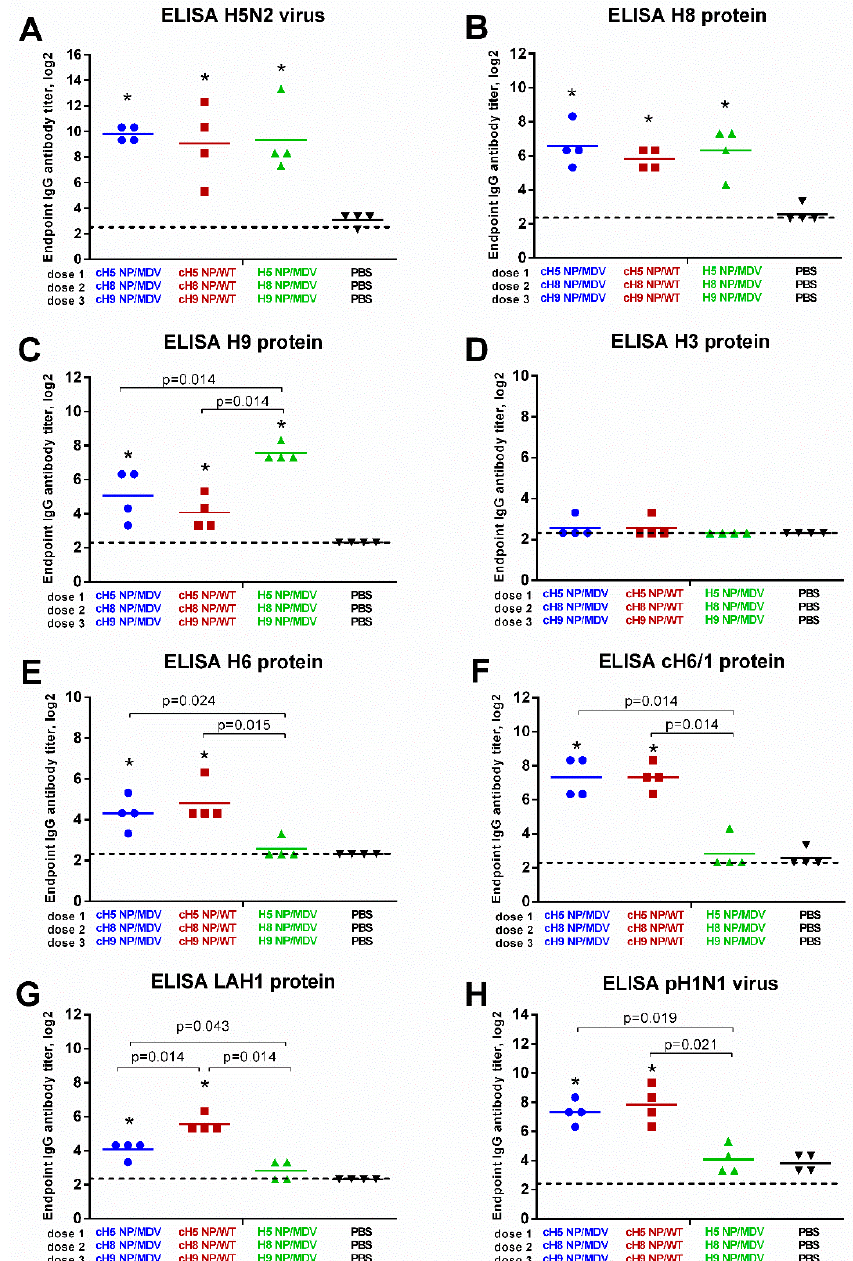
Figure 6. Cross-reactivity of the induced antibody responses. Serum IgG endpoint antibody titers in immunized ferrets were measured by ELISA against: H5 NP / MDV LAIV whole virus antigen ( A ); H8 full-length HA protein ( B ); H9 full-length HA protein ( C ); H3 full-length HA protein ( D ); H6 full-length HA protein ( E ); pH1N1 whole virus antigen ( F ); cH6 / 1 chimeric HA protein ( G ); and long alpha helix 1 (LAH1) recombinant protein ( H ). * indicates significant difference with the mock-vaccinated group. The dashed line indicates the limit of detection.